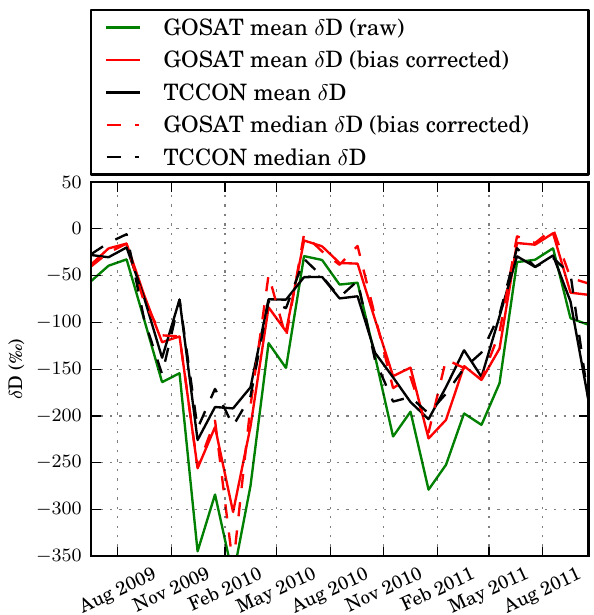
Fig. 7. Comparison of monthly δ D over the Lamont (Oklahoma) TCCON station (GOSAT coincidences within ± 2 ◦ latitude and lon- gitude). Both means and medians are displayed, underlining the non-Gaussian nature of δ -D distributions in space and time.